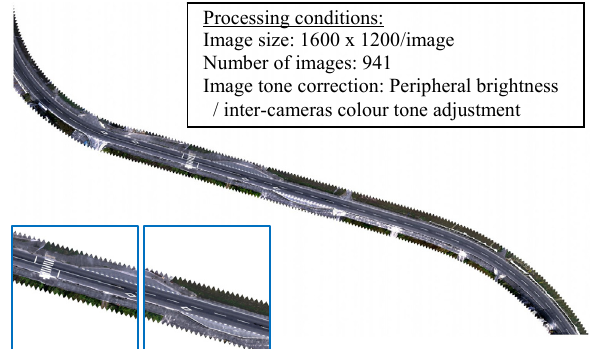
Figure 10. Example of typical ORI from “MMS-S220” Figure 11 shows the comparison of conventional orthorectified coloured point cloud imagery and ORI obtained by the proposed technique with 1cm ground resolution. The ORI generated from the proposed technique is more clear, occlusion free and with higher resolution. Influences of occlusion due to telephone poles, trees and shadow of vehicles have been adequately removed by compensating with other images.